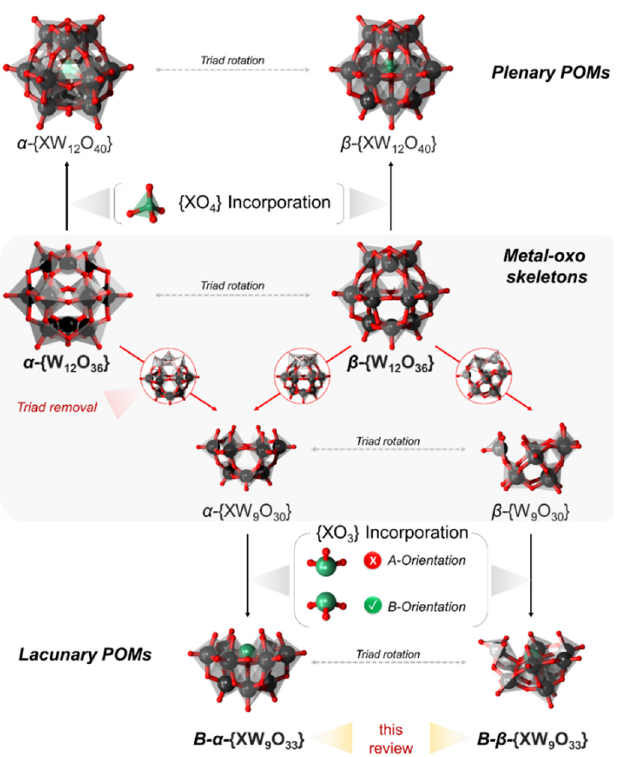
Figure 1. Concept map representation of the relationship between different metal–oxo skeletons ( middle row ) and the incorporation of tetrahedral guests {XO 4 } leading to complete plenary POMs ( top row ) or {XO 3 } guests leading to different lone pair containing lacunary POMs ( bottom row ). Color code: W = black, O = red X = green.